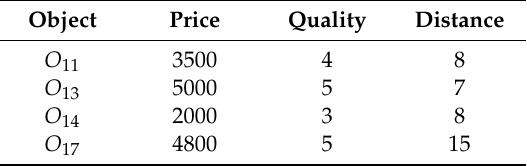
Figure 6. Query-dissemination range expansion through P 5 . Figure 6. Query ‐ dissemination range expansion through 𝑃 (cid:2873) . Table 4. Local skyline query processing result of P 5 Table 4. Local skyline query processing result of 𝑃 5 .